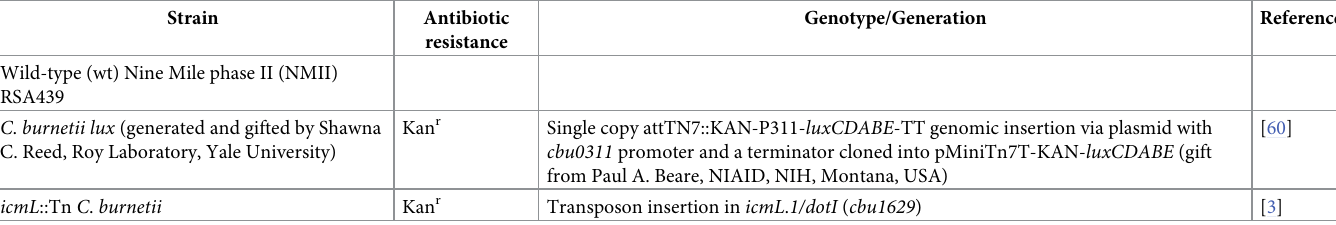
Table 1. C . burnetii strains used in this